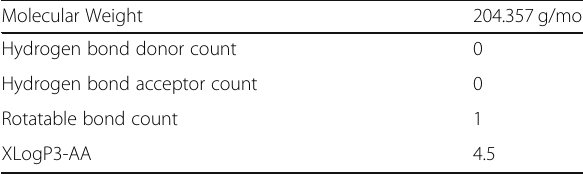
Table 2 Different physiochemical properties of copaene Molecular Weight 204.357